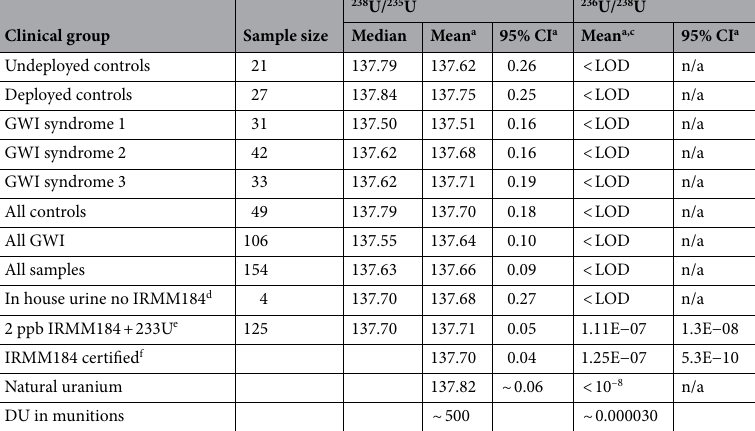
Table 3. Urinary uranium isotope ratios by Gulf War veterans’ clinical group. DU depleted uranium, IRMM European Commission’s Institute for Reference Materials and Measurements, LOD limit of detection, n/a not applicable, U uranium. a Geometric means with 95% CI. b Since 238 U/ 235 U uncertainties are not significantly asymmetrical and are reported as a single value. c The 236 U/ 238 U ratios were overwhelmingly below the 0.0000015 limit of detection after all corrections and uncertainty propagations were made. d The 4 analyses